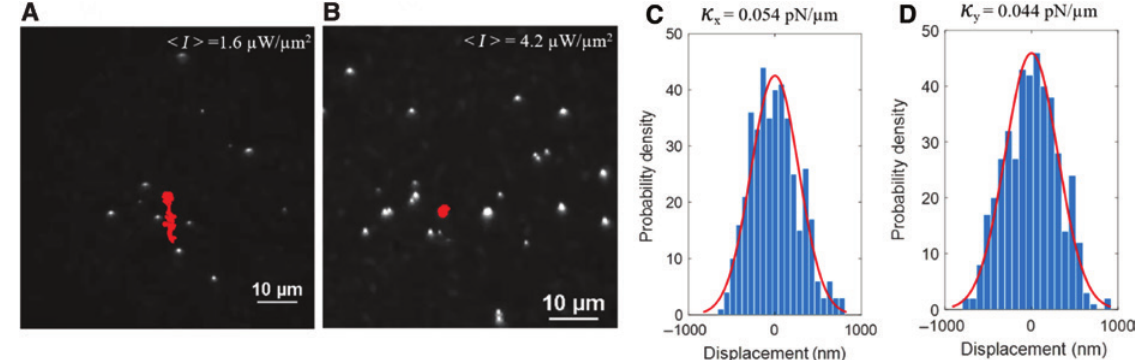
Figure 2: Large-scale trapping of particles with opto-thermoelectric speckle tweezers. Trapping of multiple 500-nm polystyrene particles in a thermal speckle field at an average speckle intensity of (A) < I > = 1.6 μ W/ μ m 2 and (B) < I > = 4.2 μ W/ μ m 2 . The red solid lines show the trajectory of one of the particles trapped in the speckle field. (C, D) Positional fluctuations in the X - and Y -direction (see Figure 1E) of a single 500-nm particle trapped at one of the speckle grain of Figure 1B. The red curves are Gaussian